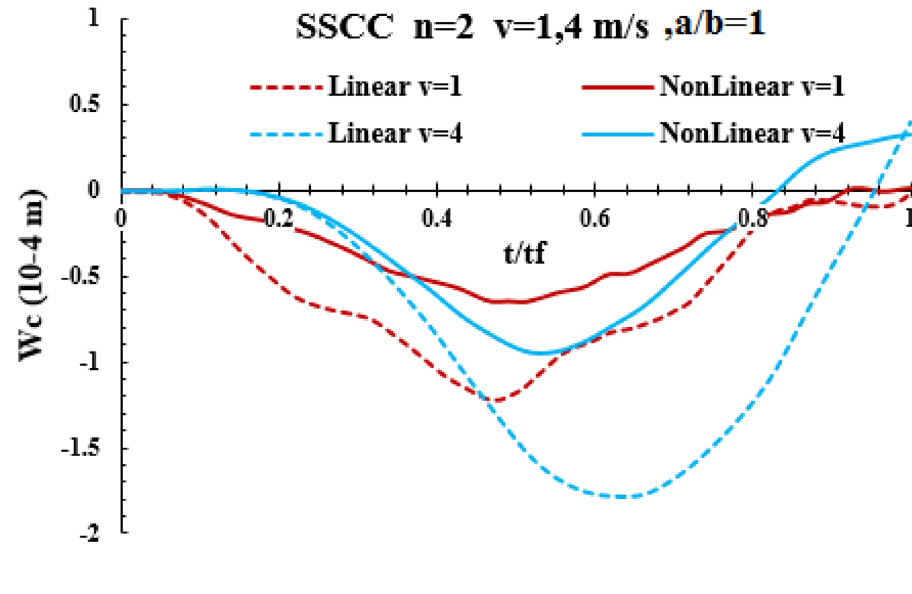
Fig. 12 The effect of material gradient index on deflection history of center-point of the plate (SSSS boundary condi-